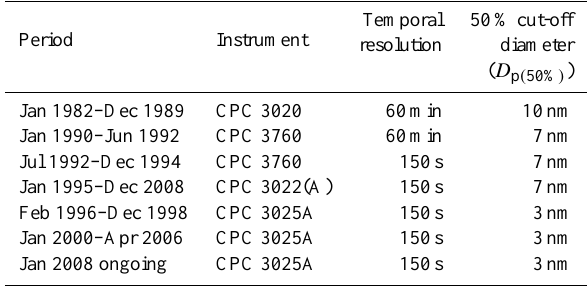
Table 1. Listing of operation periods of the different particle coun- ters types at Neumayer